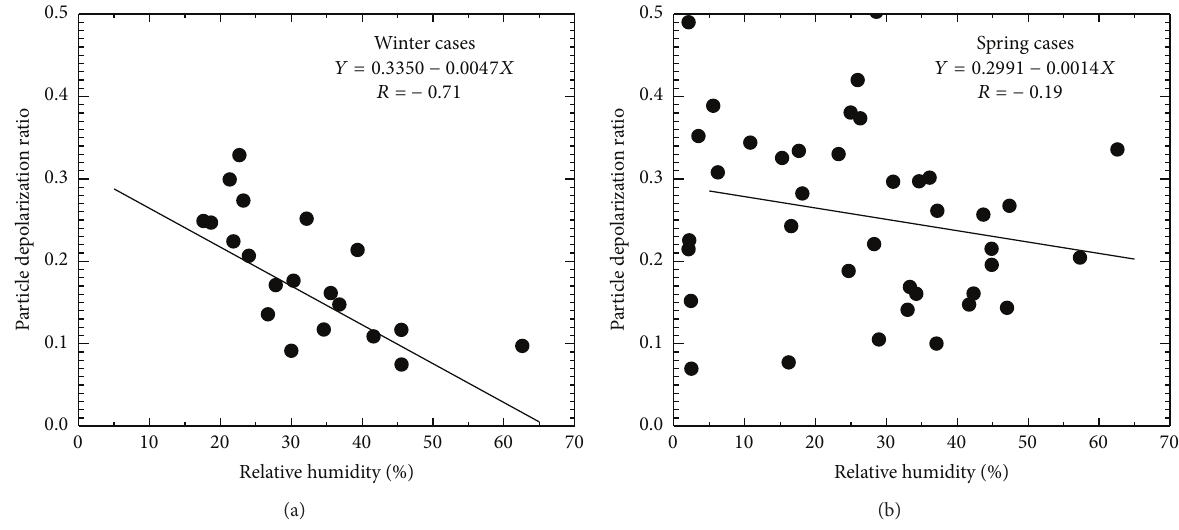
Figure 11: Scatter diagrams of the correlation between particle depolarization ratio and relative humidity measured during winter (a) and spring (b) dust events over Wuhan from October 2010 to September 2012. The relative humidity and particle depolarization ratio were simultaneously measured using the radiosondes and ground-based depolarization lidar. Here, 𝑅 represents the linear correlation